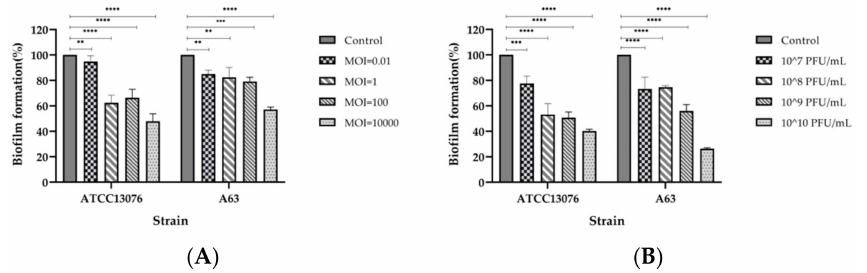
Figure 6. ( A ) Effect of phage SPJ41 on inhibition of biofilm formation of S. Enteritidis ATCC 13076 and MDR S . Derby A63. ( B ) Effect of phage SPJ41 on the removal of biofilms of S. Enteritidis ATCC 13076 and MDR S . Derby A63. Statistical comparisons were performed relative to the control using the two-way ANOVA with multiple comparisons test (**, p < 0.01; ***, p < 0.001; ****, p <